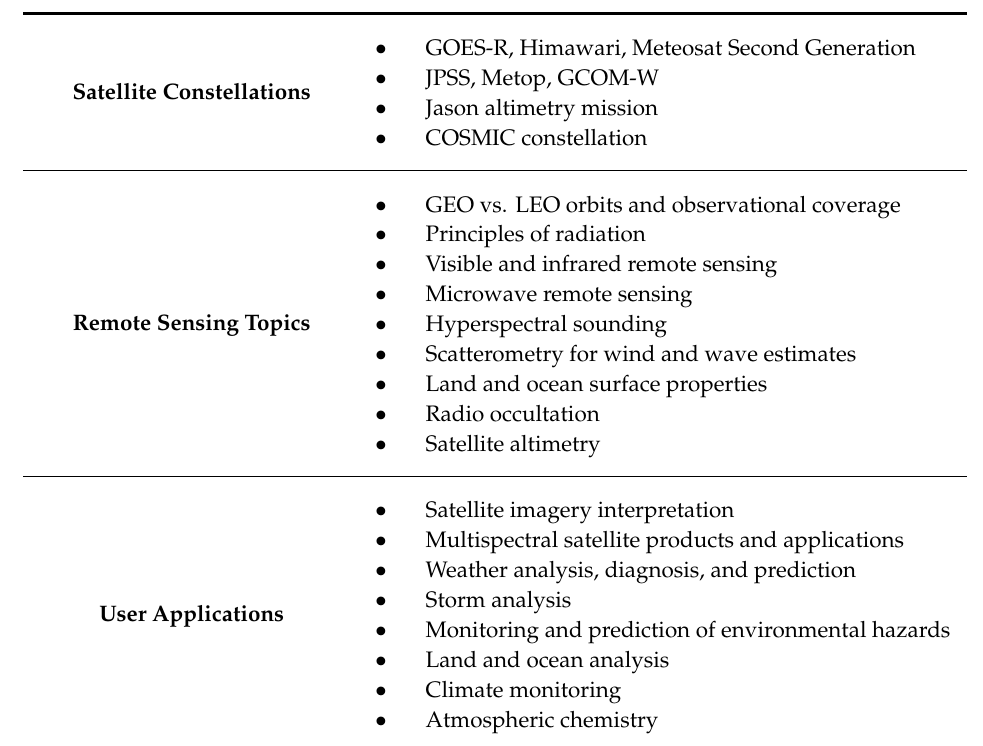
Table 1. Sampling of MetEd satellite meteorology lesson